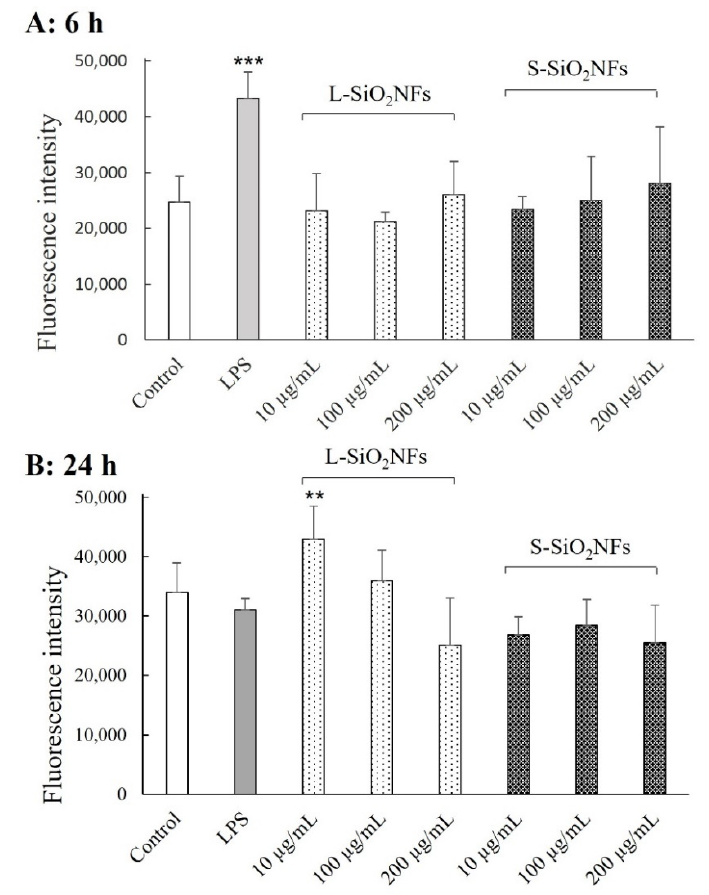
Figure 3. The effect of SiO 2 NF lengths on ROS production, detected by the H 2 DCFDA assay. THP-1 cells were seeded 3 × 10 4 /well and differentiated with PMA. THP-1-derived macrophage-like cells were treated with different SiO 2 NFs concentrations and 1 µg/mL LPS as the positive control for 6 (plot A ) and 24 (plot B ) hours. The assay was repeated 3 times, each time in triplicate. Statistical analysis was performed by one-way analysis of variance, *** p < 0.001 and ** p = 0.003 ( n = 9). The proinflammatory cytokines such as TNF- α and IL-1 β are required for activation of the innate immune response and mediation of the recruitment, activation, and adherence of circulating phagocytic cells (macrophages and neutrophils) [29]. In the following experiments, we studied the ability of L- and S-SiO 2 NFs to increase TNF- α and IL-1 β production. The levels of TNF- α and IL-1 β produced by treated THP-1-derived macrophage-like cells are graphically expressed in Figure 4A and Figure 4B, respectively. After the treatment with L-SiO 2 NFs, there was only a small increase in cytokine production for the highest tested concentration of L-SiO 2 NF. On the other hand, the cellular response to S-SiO 2 NF was much more prominent. The highest concentration of S-SiO 2 NF (200 µg/mL) caused an increase in both measured cytokines, especially in IL-1 β production. The results indicated that TNF- α and IL-1 β expression and, thus, inflammation is concentration-dependent and can be induced by S-SiO 2 NFs but not by L-SiO 2 NFs.